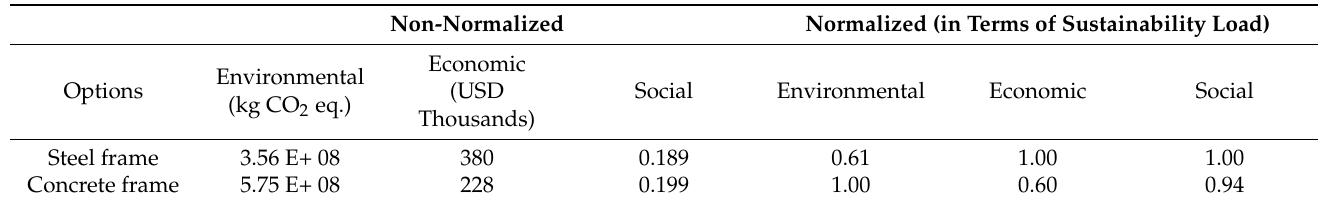
Table 7. Non-normalized and normalized un-weighted scores for final outputs in each dimension.